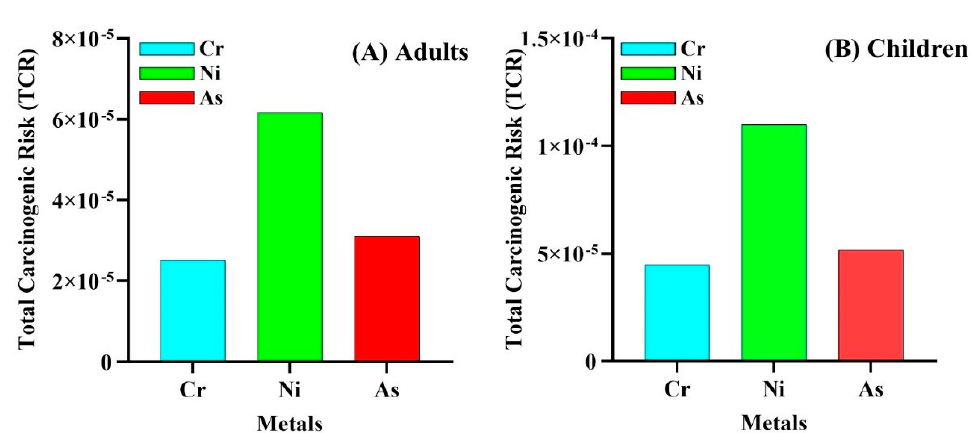
Figure 5. The metals total carcinogenic risks (TCR): ( A ) adult; ( B ) child. According to USEPA, CR and TCR values below 1 × 10 − 6 are considered negligible and indicate that the subject element is noncarcinogenic, values above 1 × 10 − 4